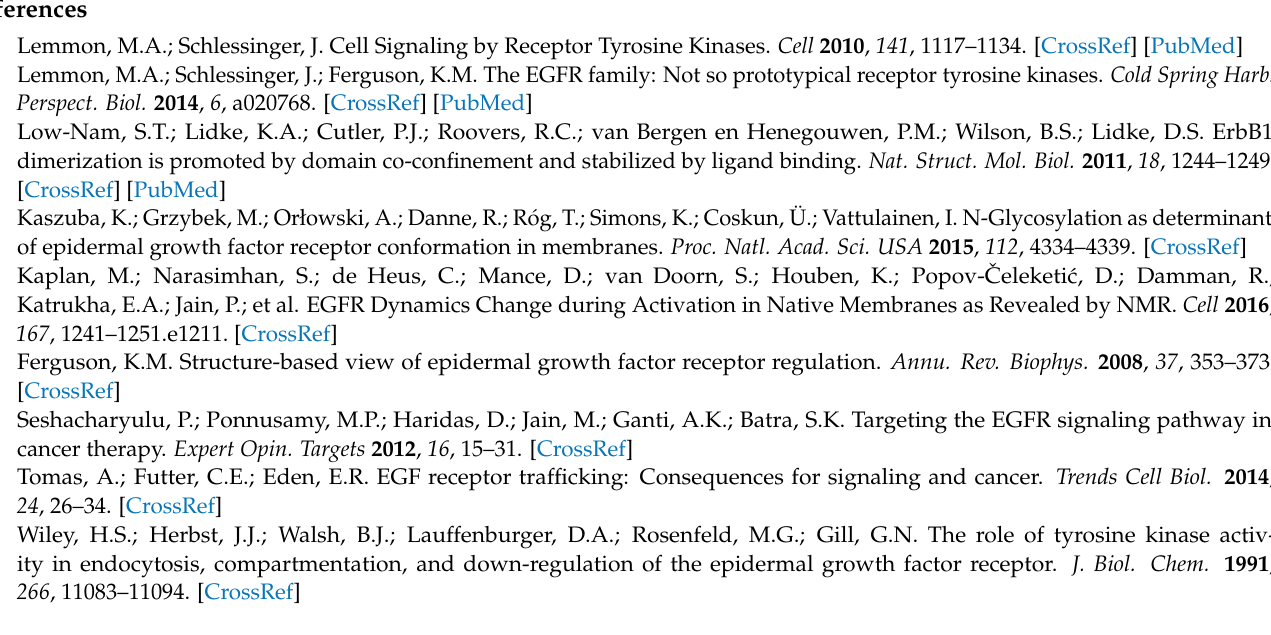
Figure S3: HPLC analysis of DSF-102 ; Figure S4: 1H-NMR of DSF-102 ; Figure S5: 13C-NMR of DSF-102 ; Figure S6: results from MD studies; Table S1: list of screened compounds, SMILES code and % of inhibition at 50 and 10 µ M